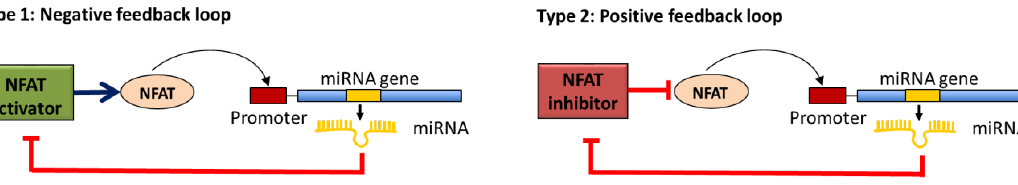
Figure 2. Schematic representation of feedback loops regulating the calcineurin/NFAT signaling pathway. In a negative feedback loop (type 1), miRNAs transcribed by NFAT inhibit NFAT activation, whereas in a positive feedback loop (type 2), miRNAs transcribed by NFAT repress the expression of the NFAT inhibitor which results in the activation of NFAT.